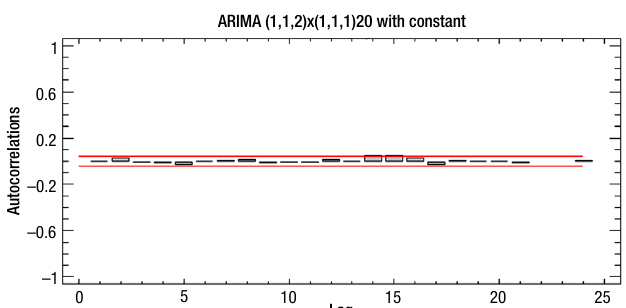
Fig. 7. Time sequence plot for time series of Overnight 2000–2008